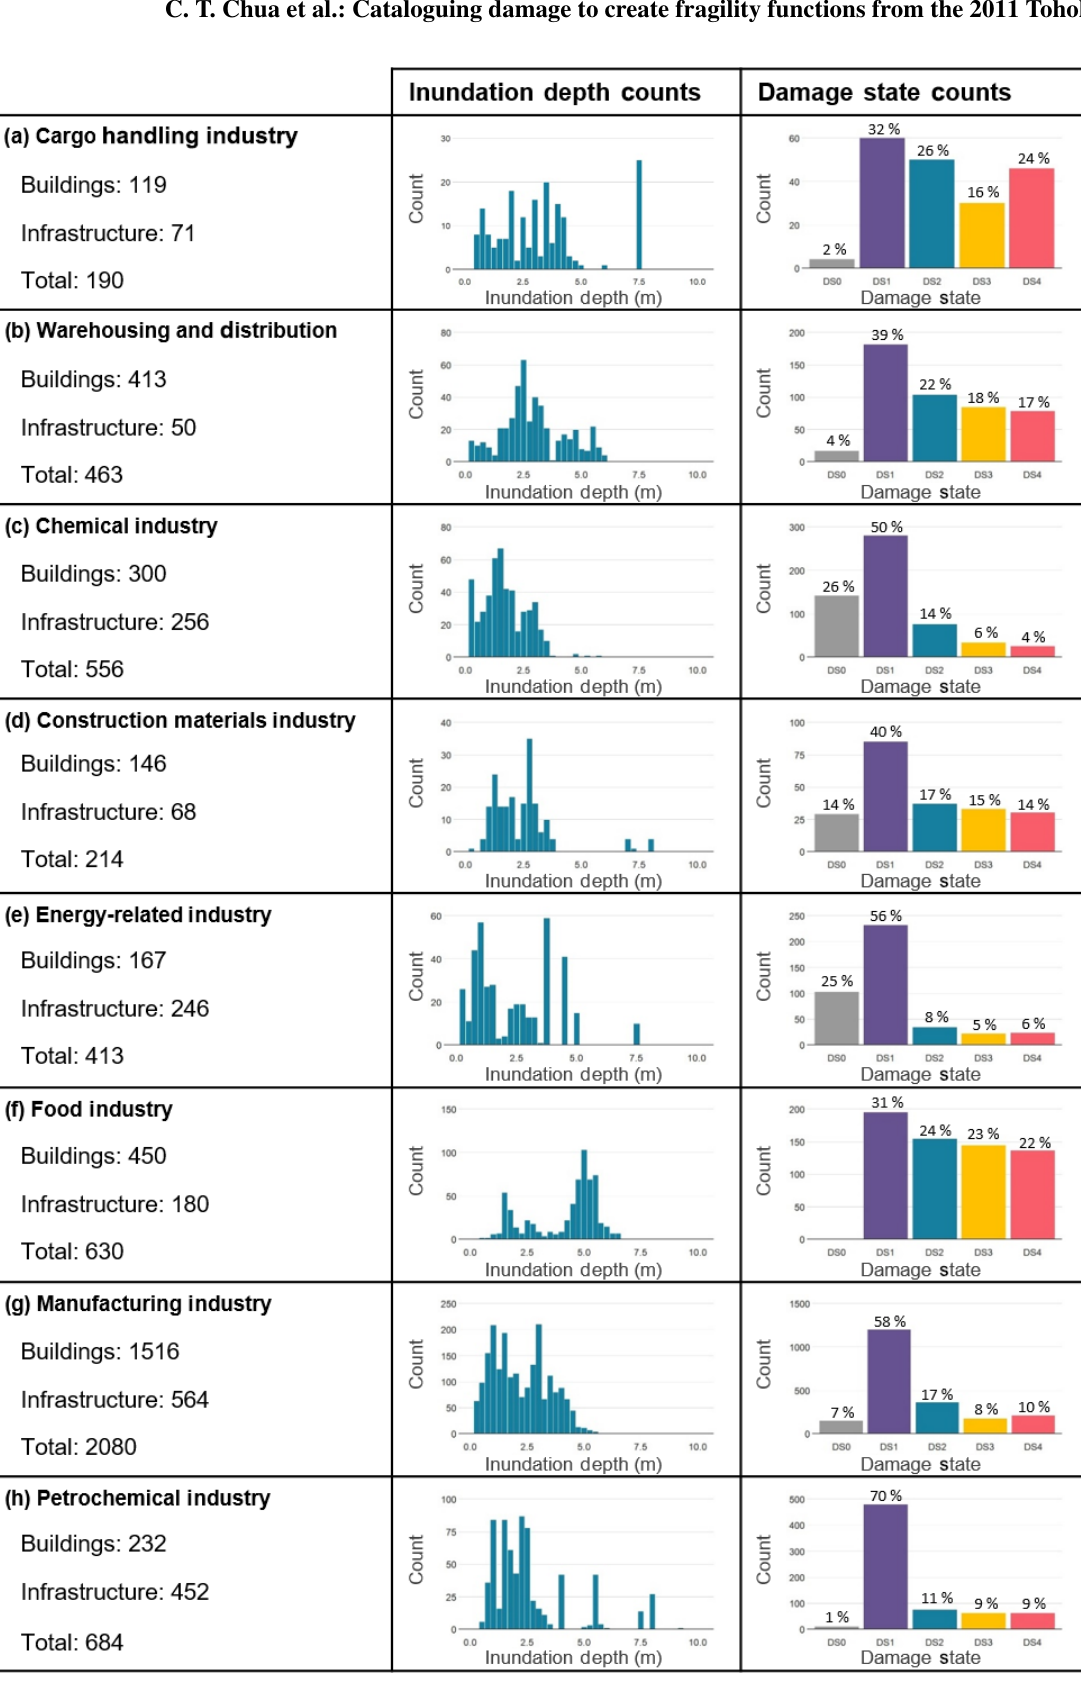
Figure 7. Data attributes of the port industries affected by the 2011 Great East Japan